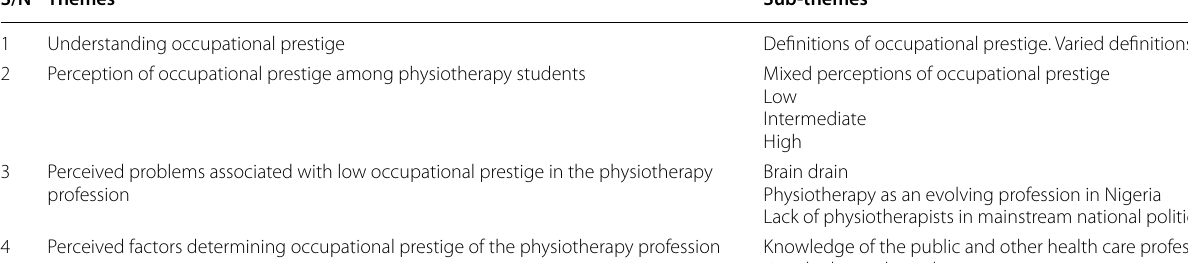
Table 5 Themes and subthemes of the qualitative study S/N